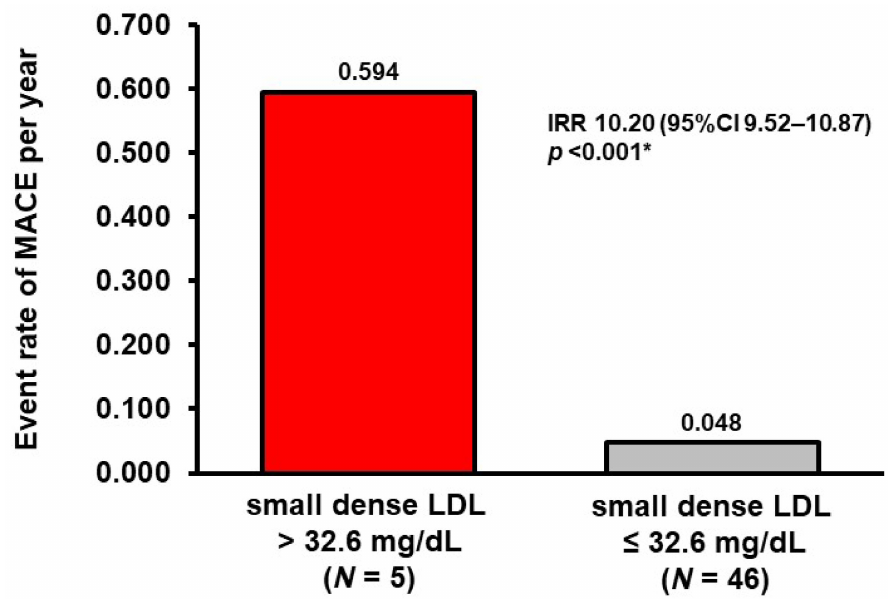
Figure 4. The rate of MACE during the observational period stratified by the level of small dense LDL cholesterol. * p < 0.05 by negative binomial regression analysis. MACE, major adverse cardiac event; LDL, low-density lipoprotein; IRR, incidence rate ratio. Table 5. Laboratory data